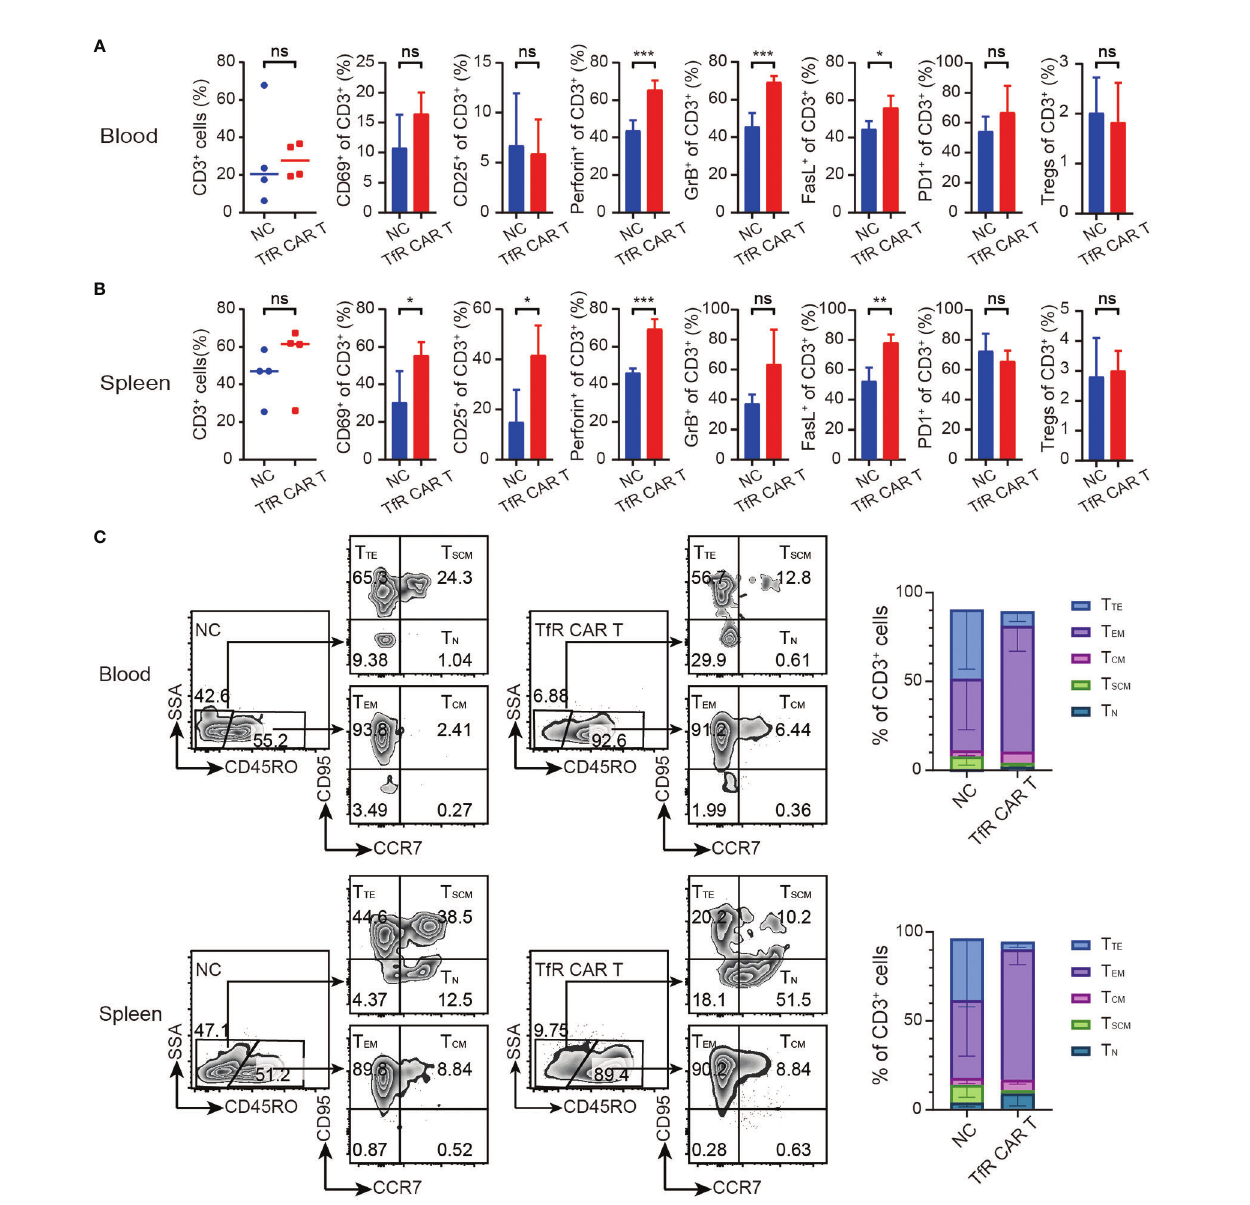
FIGURE 5 | Characteristics of in vivo TfR-CAR T cells. Percentages and status of transferred human T cells in blood (A) and spleen (B) were analyzed by FCM. Tregs were de fi ned as CD4 + CD25 + Fop3 + of CD3 + cells. All data are presented as means ± SD. * P < 0.05, ** P < 0.01, *** P < 0.001, ns indicates no statistical differences. (C) Percentages of T TE (Terminal effector, CD45RO − CCR7 − CD95 + ), T EM (Effector memory, CD45RO + CCR7 − CD95 + ), T CM (Central memory, CD45RO + CCR7 + CD95 + ), T SCM (Stem cell memory, CD45RO − CCR7 + CD95 + ), and T N (naïve, CD45RO − CCR7 + CD95 − ) subtypes in CD3 + populations were measured by FCM. Representative FCM images (left) and stacked bar graphs (right) were shown. n = 4 per